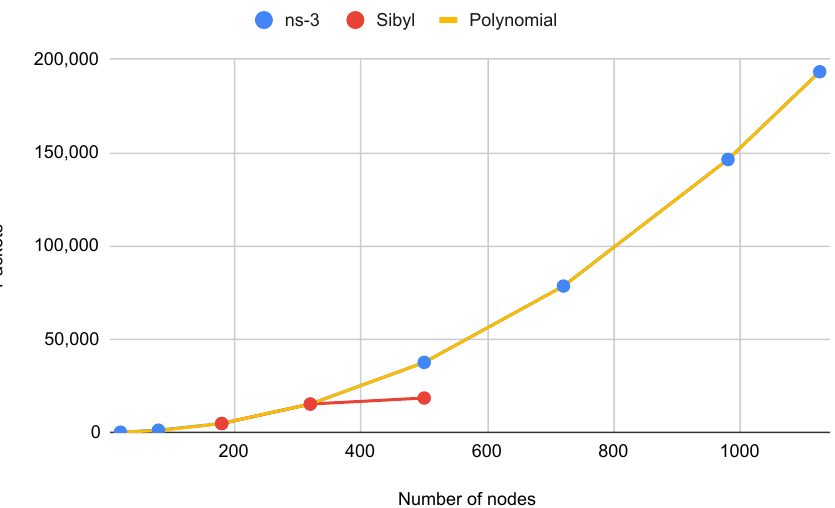
Figure 4. Evolution of the results of ns-3 and Sibyl for the Spine failure scenario, in comparison with the evolution of the polynomial k 4